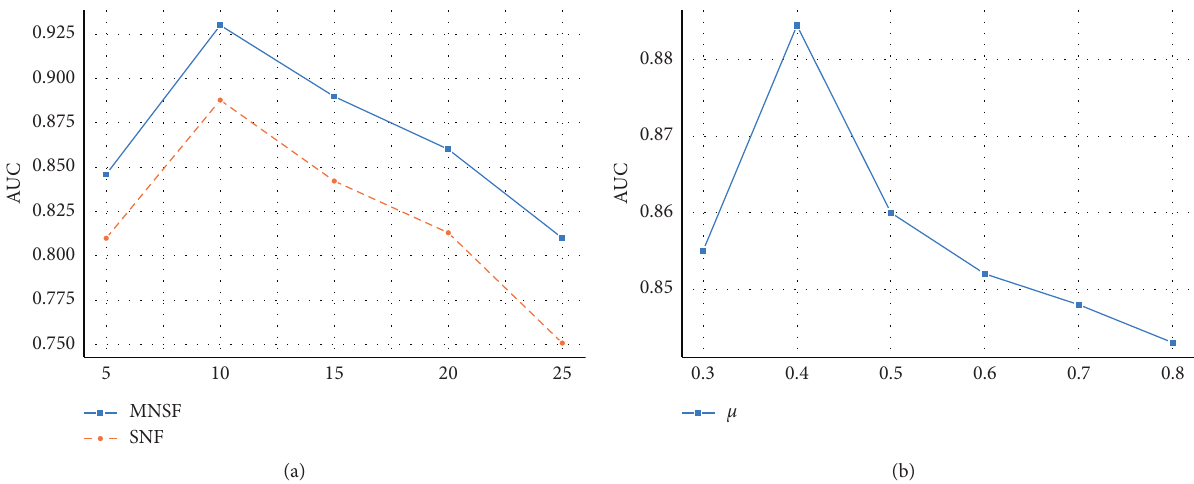
Figure 9: Impact of two parameters on area under curve (AUC) scores for models in link prediction task. (a) Impact of the nearest neighbor parameter K on MNSF and SNF. (b) Impact of the hyperparameter μ on MNSF.